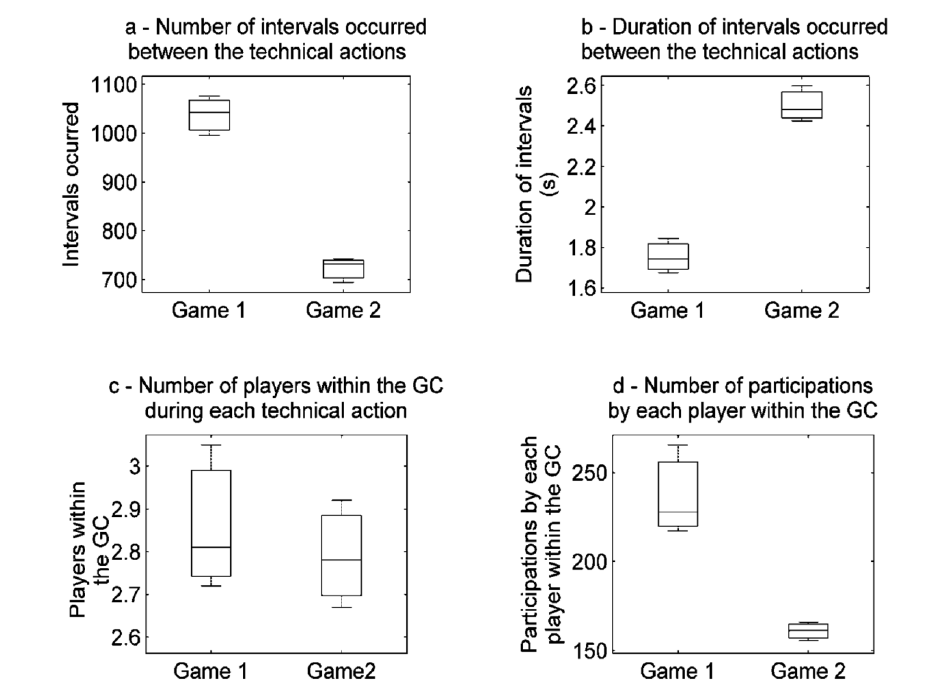
Figure 3. Box plot of the number of intervals that occurred between the technical events (a); Box plot of the intervals duration that occurred be- tween the technical events (b); Box plot of the number of players within the game centre (GC) during each technical action (c); and Box plot of number of participatory events by each player within the GC